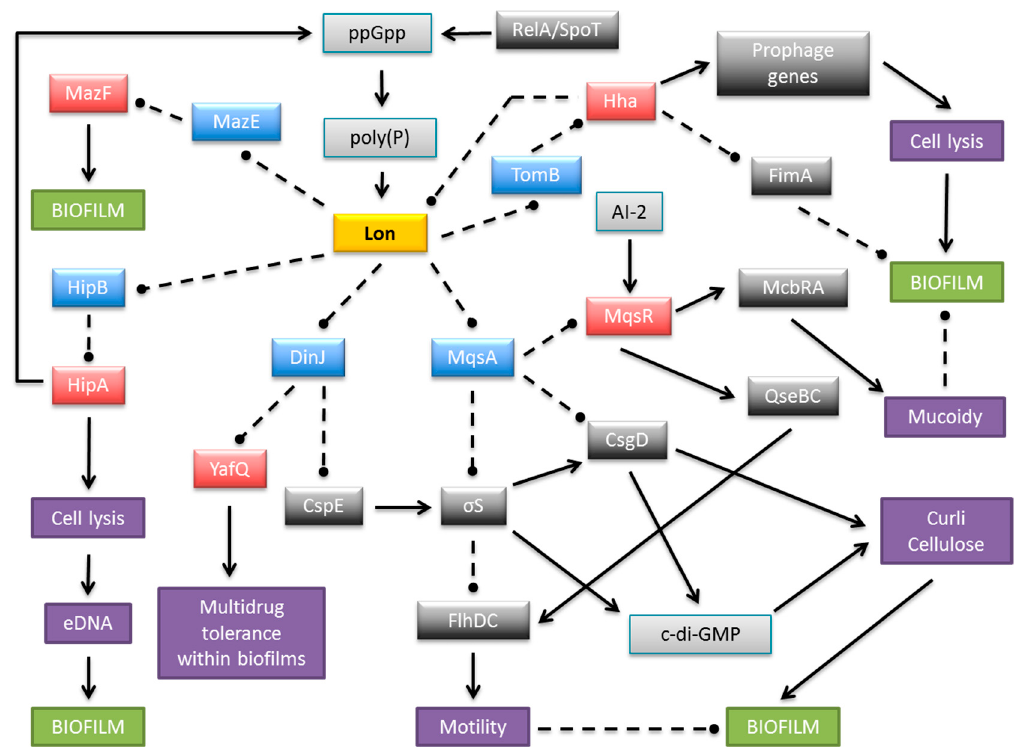
Figure 3. Schematic representation of a complex and multilayered protein network engaged in biofilm development in E. coli via TA systems. The central part illustrates Lon protease as an example of antitoxin degrading proteases, which also include ClpXP and ClpAP. Only the relevant, most well-described interactions are displayed. Coloured boxes denote toxins (red), antitoxins (blue), Lon protease (yellow), other proteins (dark grey), small molecules (light grey), and cellular processes and structures (purple). Arrows, stimulation; broken lines ending in balls, inhibition.